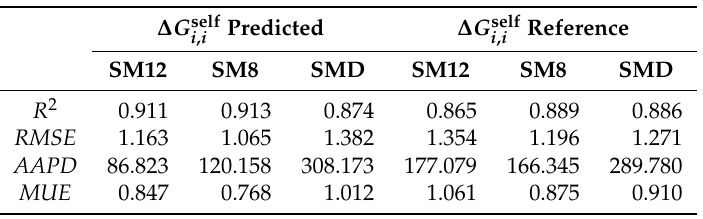
Table 4. A summary of the squared correlation coefficient ( R 2 ), root mean square error ( RMSE ), and mean unsigned error ( MUE ) for ln γ ∞ , and the average absolute percent deviation ( AAPD ) for γ ∞ i , j i , j predicted using the SM12, SM8, and SMD universal solvent model as compared to the reference data from DECHEMA. For the predictions, we compare the case where (1) ∆ G self is predicted using the i , i SM12, SM8, and SMD universal solvent model, and where (2) ∆ G self is computed using reference data, i , i as indicated. ∆ G self Predicted ∆ G self Reference i , i i , i